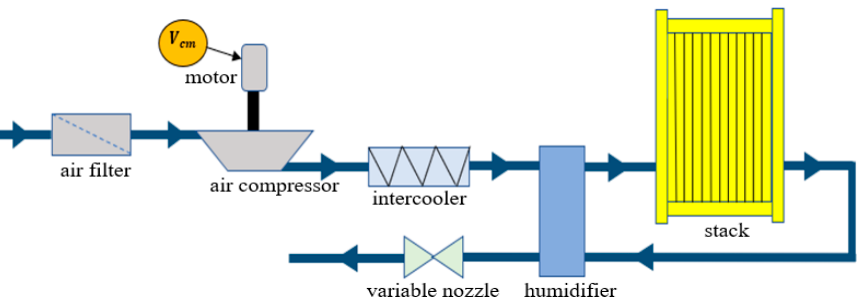
Figure 1. PEMFC air supply system.